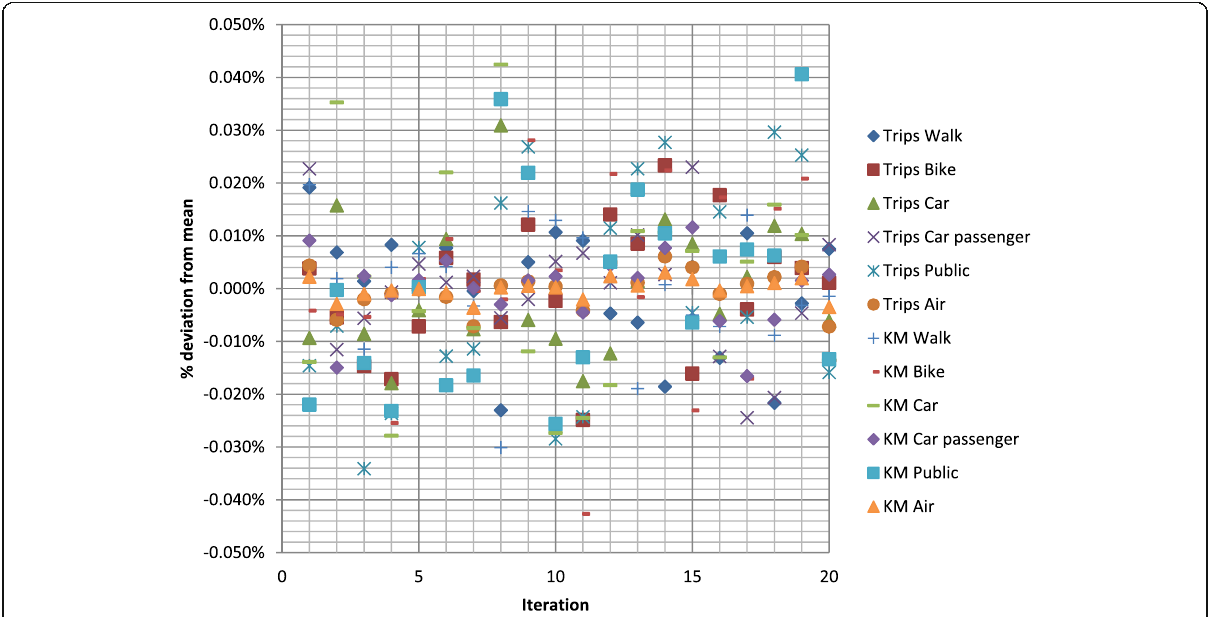
Fig. 6 Accumulated noise in final trips and mileage cause by the household simulation